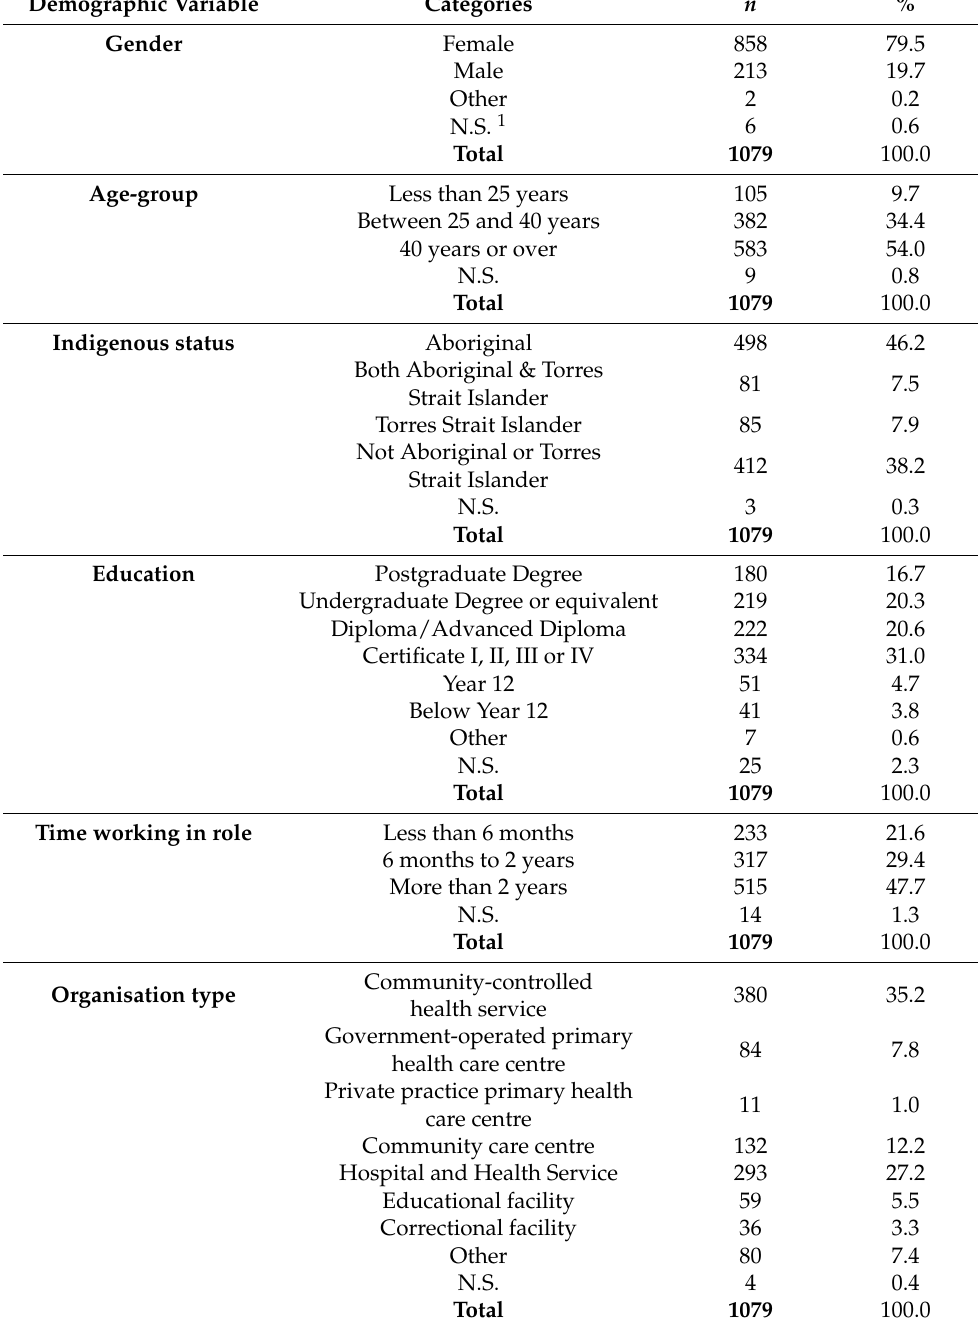
Table 1. Workshop participant demographics, frequencies and percentages (June 2017 to July